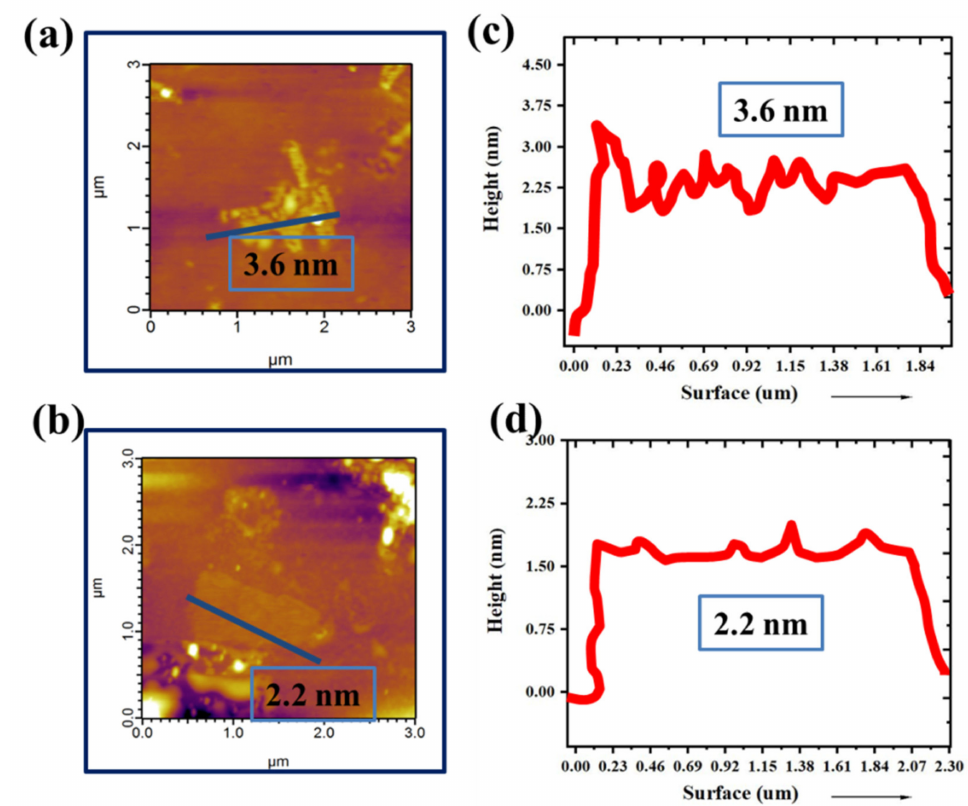
Figure 2. ( a , b ) Atomic force microscope (AFM) image and ( c , d ) thickness profile of graphene (drop casted on silicon